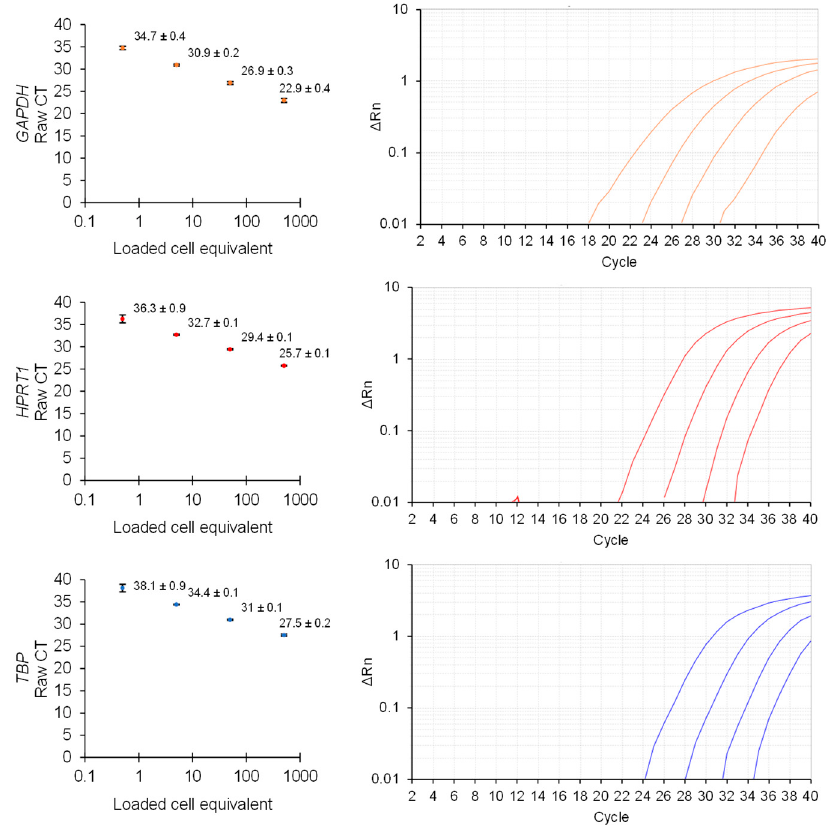
Figure 2. Gene expression population titration of an optimized one-step direct lysis method. The fibroblast cell culture lysate was diluted and analyzed by one-step RT-qPCR for the detection of housekeeper gene expression ( n = 3, error presented as the standard error of the mean (SEM)) and representative amplification curves.